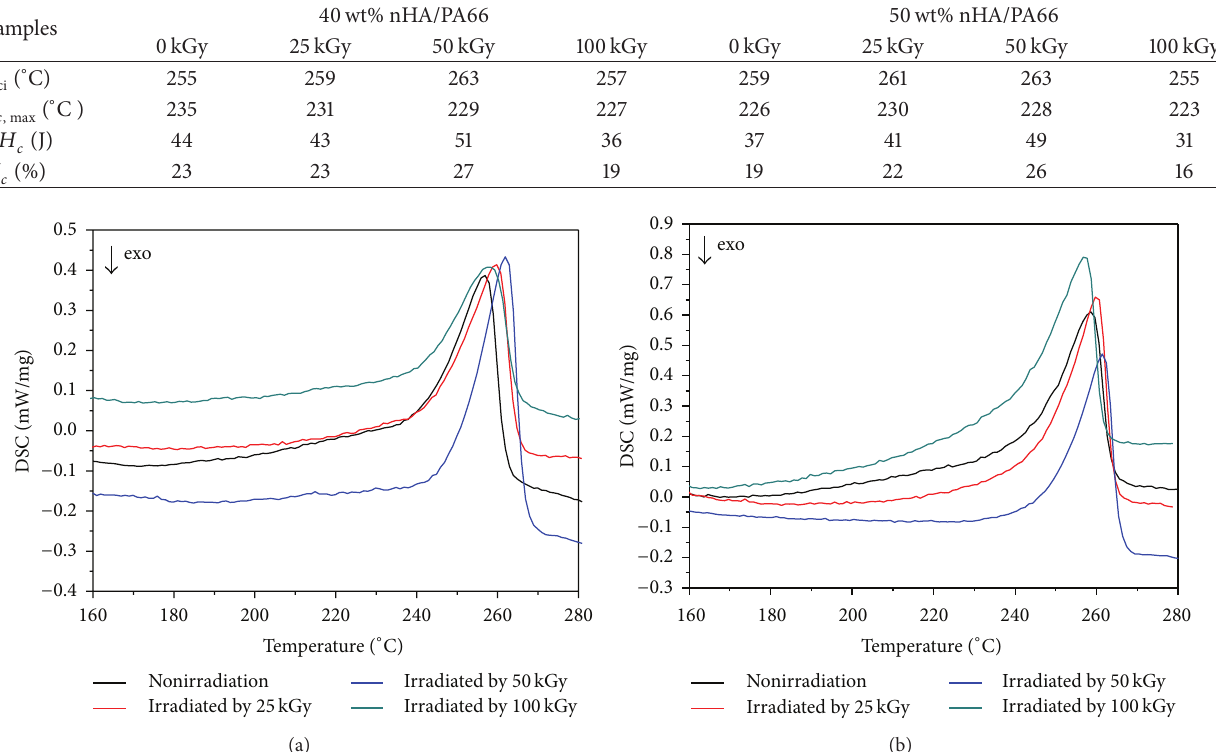
Figure 4: The effect of irradiation dose on curves for the melting of 40 wt% (a) and 50wt% (b) nHA/PA66 composites.